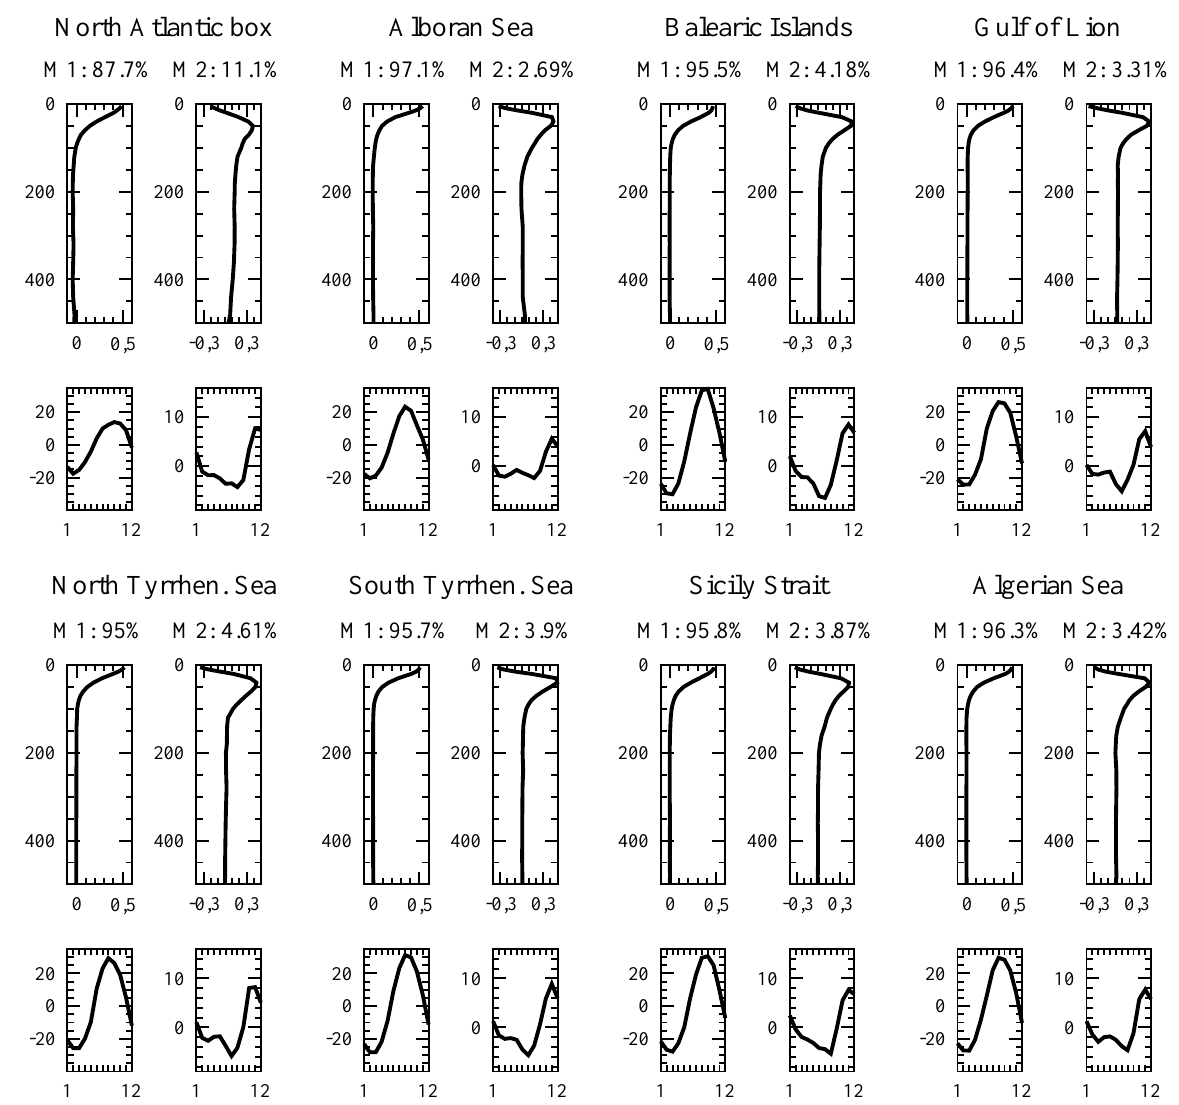
Fig. 13. West Mediterranean: eigenfunctions F 1 (z) and F 2 (z) (m/s) between 5 and 500m, and the associated coefficients α 1 (t) and α 2 (t) .